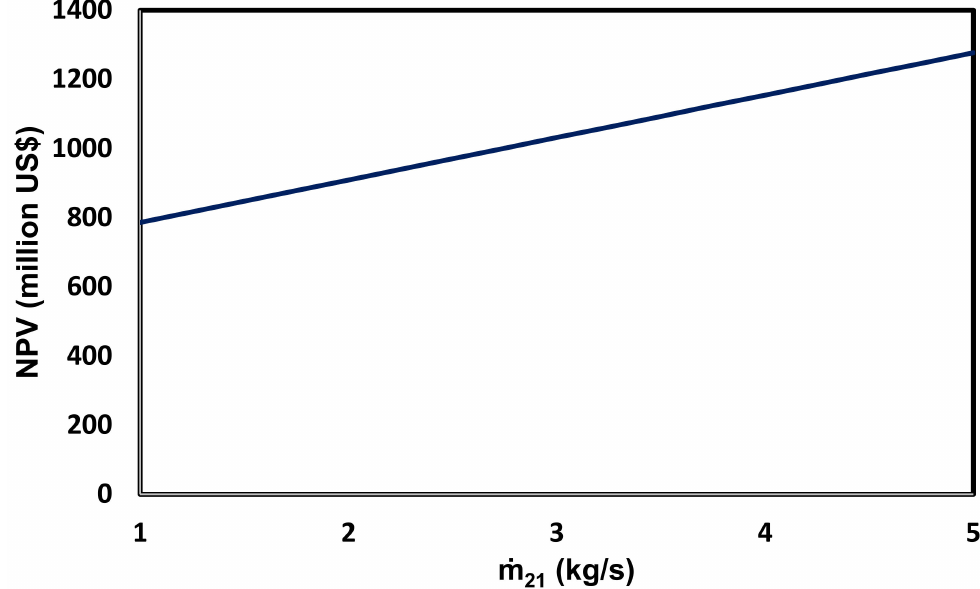
Figure 12. The variation in system NPV with the feed seawater mass flow